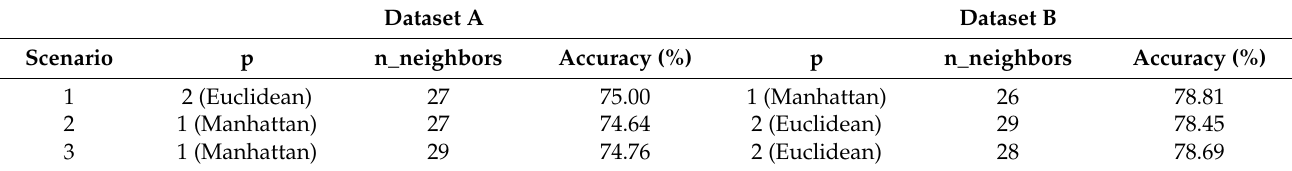
Table 9. Model’s accuracy and the optimal hyperparameters in k